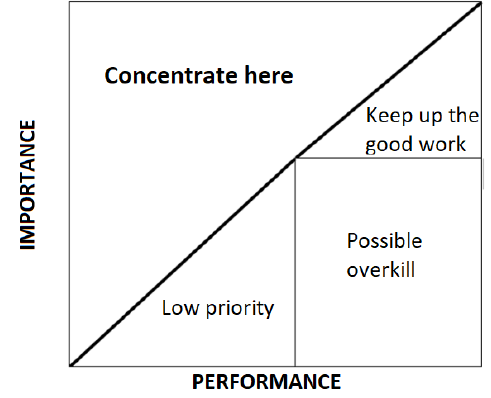
Figure 1. Importance-performance analysis (IPA) matrix.